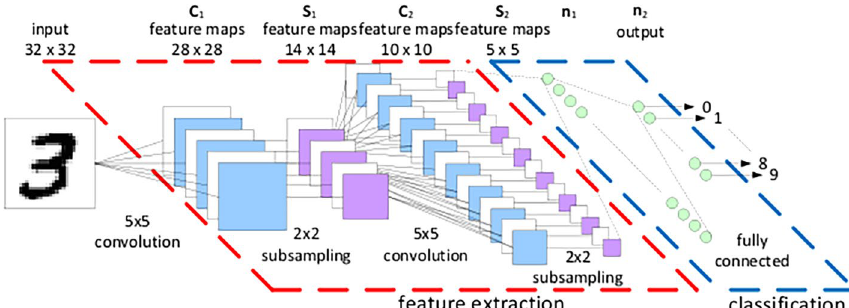
Fig. 4 Structure of a convolutional neural